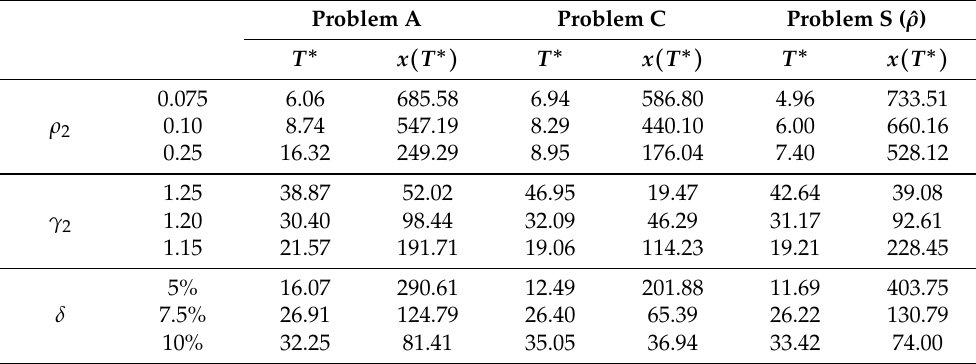
Table 2. Sensitivity